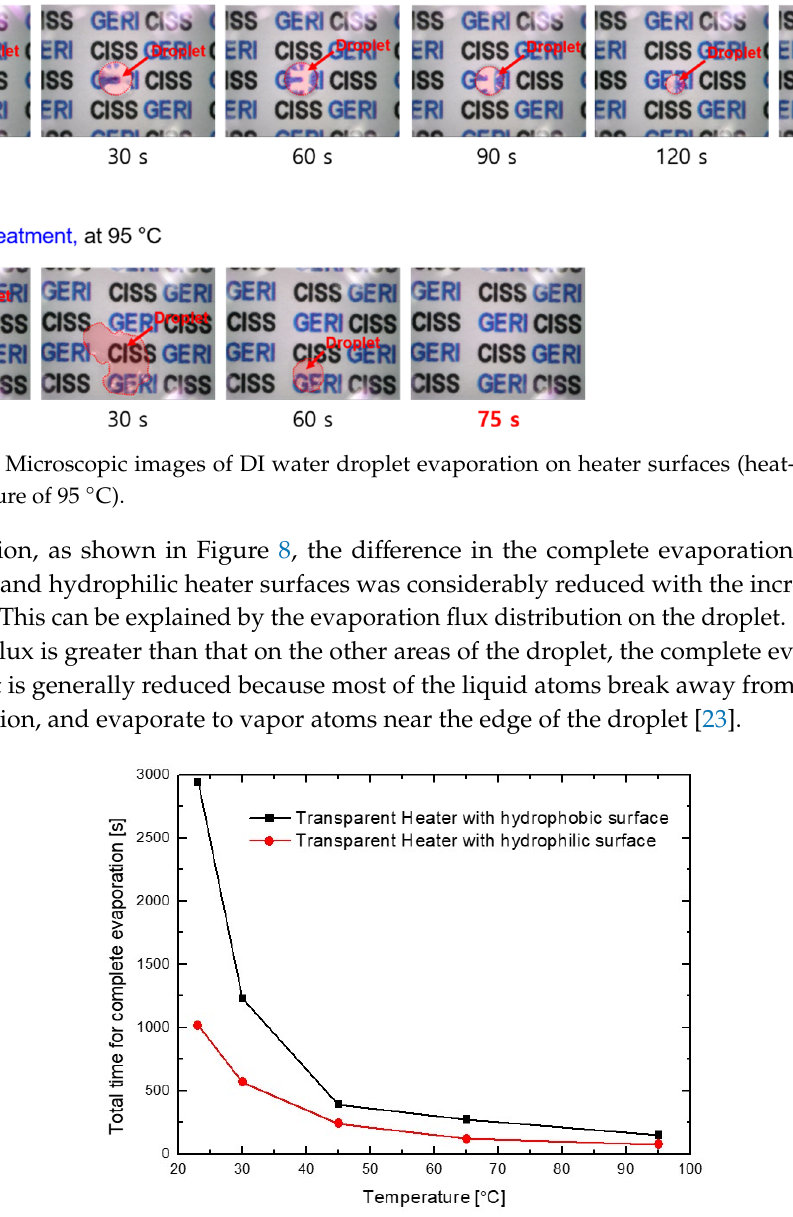
Figure 8. Total duration for complete water droplet evaporation on ITO / Ag / ITO multilayer transparent heater surfaces with different wetting properties and heating temperatures (room-temperature, 30, 45, 65, and 95 °C).